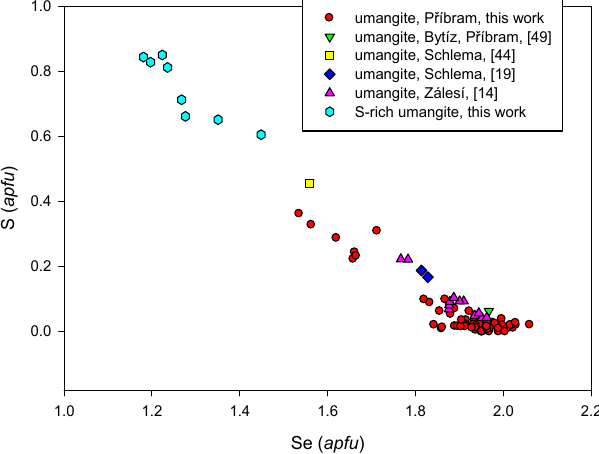
Figure 75. Se vs. S ( apfu ) graph for umangite from P ř íbram and other localities.